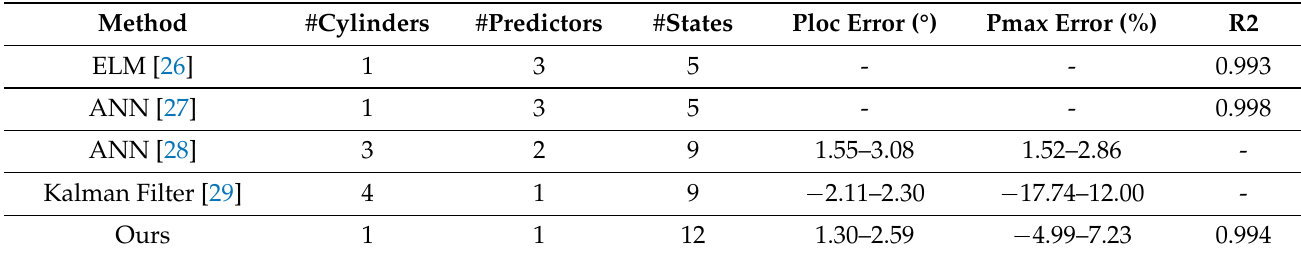
Table 6. Method comparison results. The Pmax error (%) and the Ploc error (°) are shown as the lower bound-upper bound performance. The best R2 is reported. The state-of-the-art abbreviations stand for: ELM: Extreme Learning Machine, ANN: Artificial Neural Networks. : not −